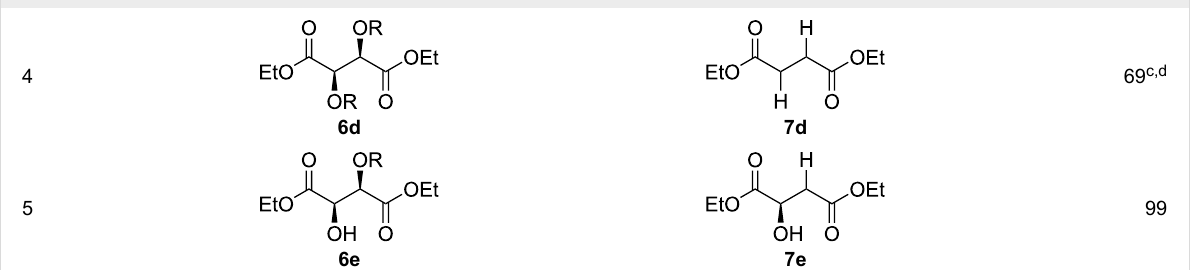
Table 4: Preparative deoxygenation reactions of non-benzylic benzoates. a